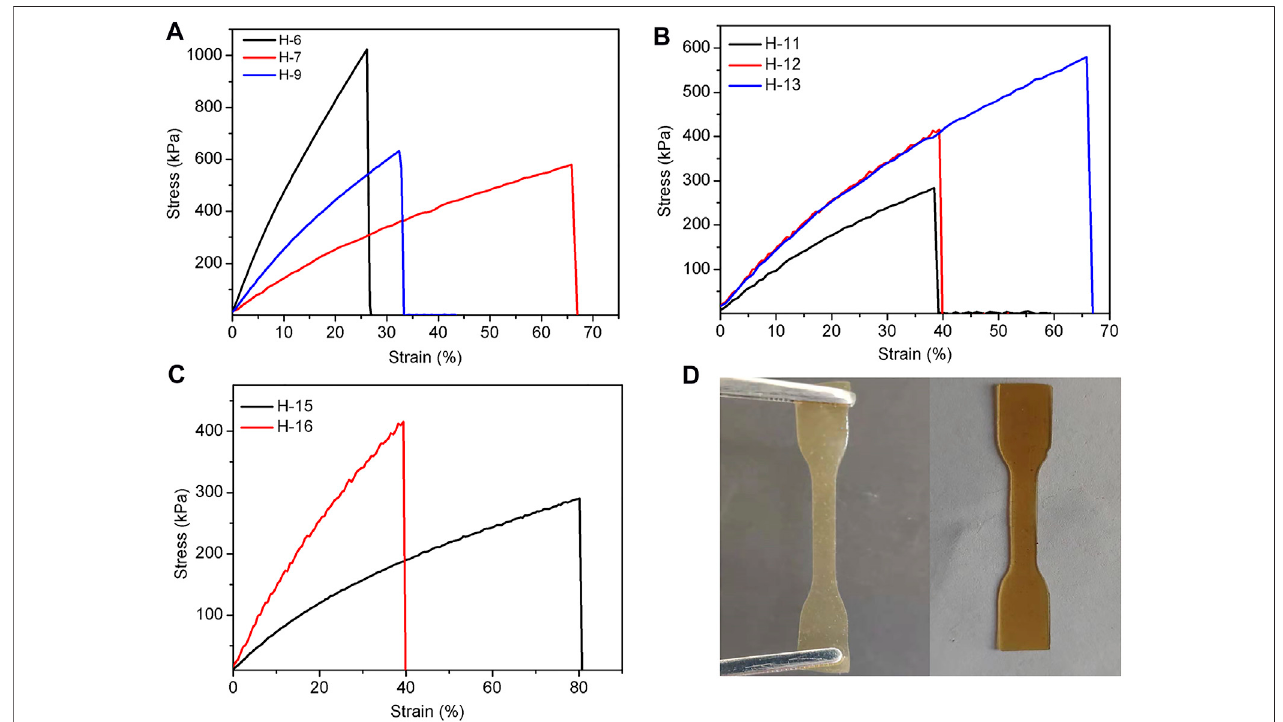
TABLE 2 | Mechanical properties of hydrogen bond cross-linked